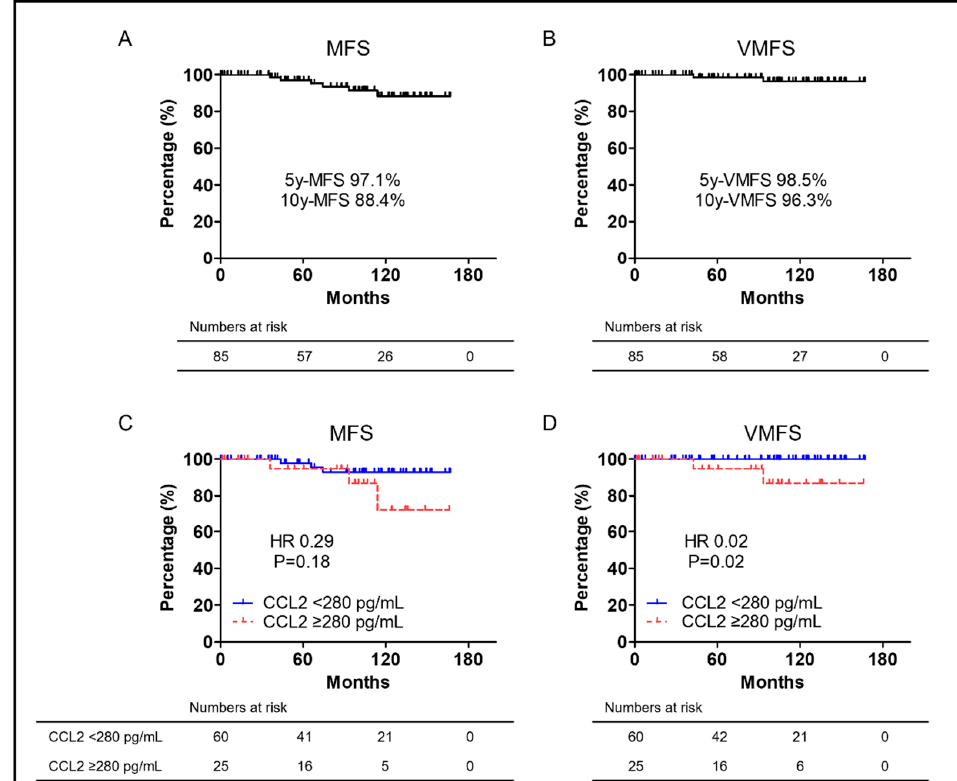
Figure 4. ( A ) Kaplan–Meier curves of MFS in nmCSPC. ( B ) Kaplan–Meier curves of VMFS in nmCSPC. ( C ) Kaplan–Meier curves of MFS in in nmCSPC with CCL2 ≥ 280 pg/mL and CCL2 < 280 pg/mL. ( D ) Kaplan–Meier curves of VMFS in in nmCSPC with CCL2 ≥ 280 pg/mL and CCL2 < 280 pg/mL. Numbers at risk for each group are shown at the bottom of the figure. MFS, metastasis-free survival; VMFS, visceral metastasis-free survival; HR, hazard ratio; and nmCSPC, non-metastatic castration-sensitive prostate cancer.